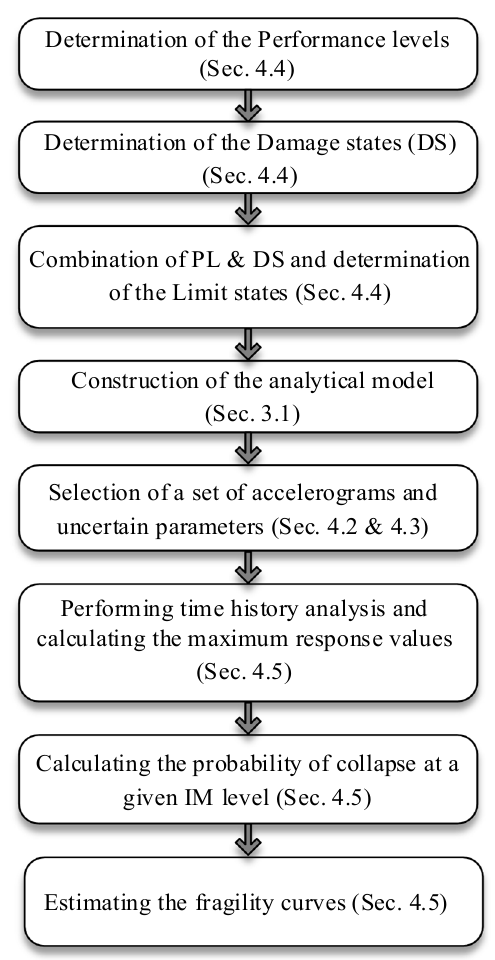
Figure 11. Flowchart of seismic vulnerability assessment process.